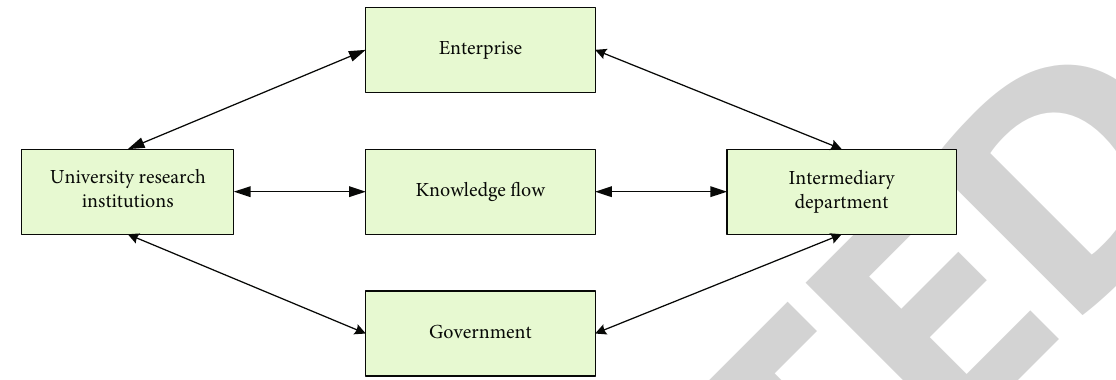
Figure 4: National knowledge innovation system structure.